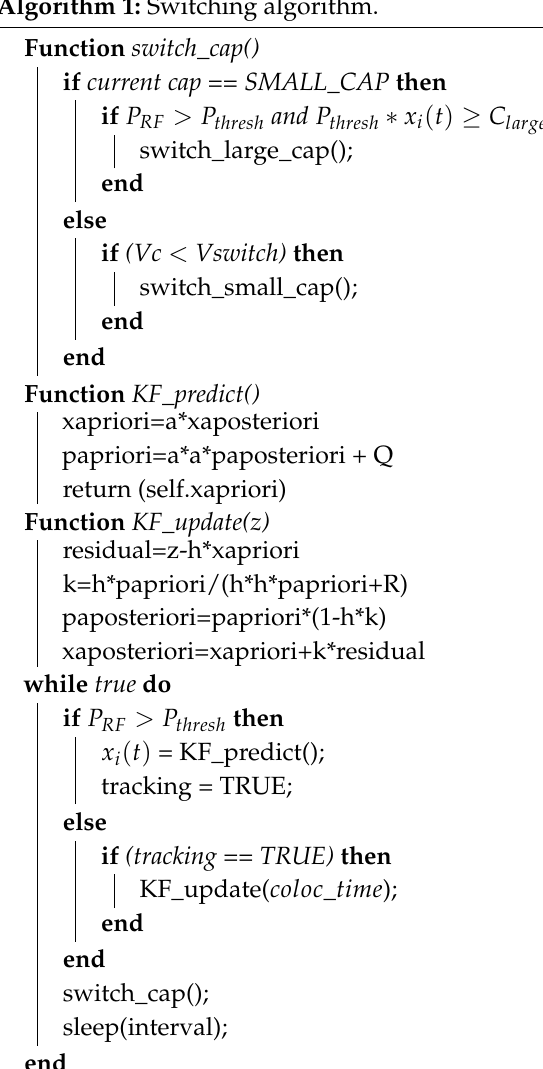
Algorithm 1: Switching